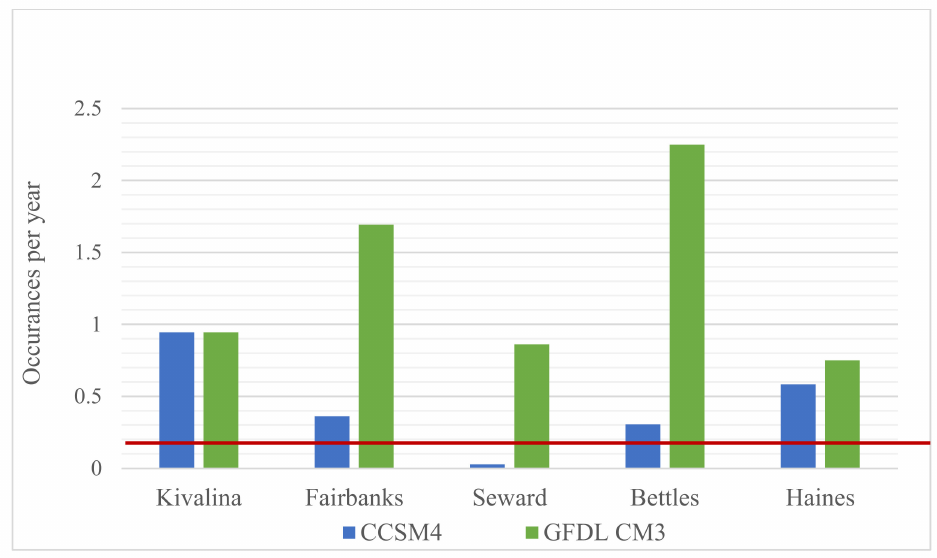
Figure 9. As in Figure 8, but for 7 day precipitation events.